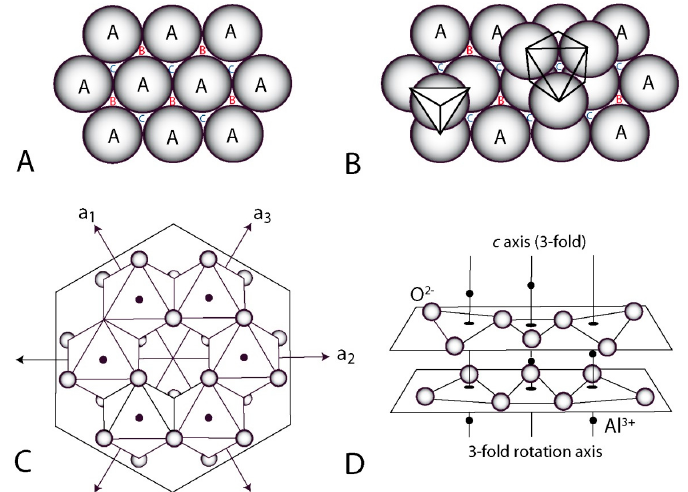
Figure 5. The crystal structure of corundum. ( A ) A single layer of spheres representing oxygen atoms in hexagonal close packed coordination. In a second layer the spheres would be oriented over the B locations, and a third layer would be over the first (A locations); ( B ) six oxygen atoms coordinate Al atoms at the C positions forming an octahedron (the tetrahedral coordinated site is vacant). Only two out of every three Al sites are occupied in the Al layers; ( C ) the crystal structure of corundum looking down c ; and ( D ) perspective view of the crystal structure of corundum [5,40]. If there are no cation substitutions in the structure, corundum is colorless. However when chromophorous elements replace aluminum in the octahedral site, the crystal is colored. The substitution of Al 3+ by Cr 3+ results in pink to red colors, depending on the Cr content. The pink corundum variety is called “pink sapphire” or “pink ruby”, and the red variety, with higher Cr contents (0.1 < Cr 2 O 3 < 3.0 wt %; [5]), is called “ruby”. However, the distinction between these two varieties is not yet well defined and is debated by gem dealers and laboratories. As such, in the present work, pink corundum crystals that are associated with deep red ruby in some deposits worldwide will be considered rubies from here onward. Concentrations of 9.4 wt % Cr 2 O 3 were measured in ruby from Karelia in Russia [41] and up to 13 and 13.4 wt % respectively, in ruby from Westland in New Zealand [42], and in ruby inclusions in diamond from placers associated with the Juina kimberlite [43].